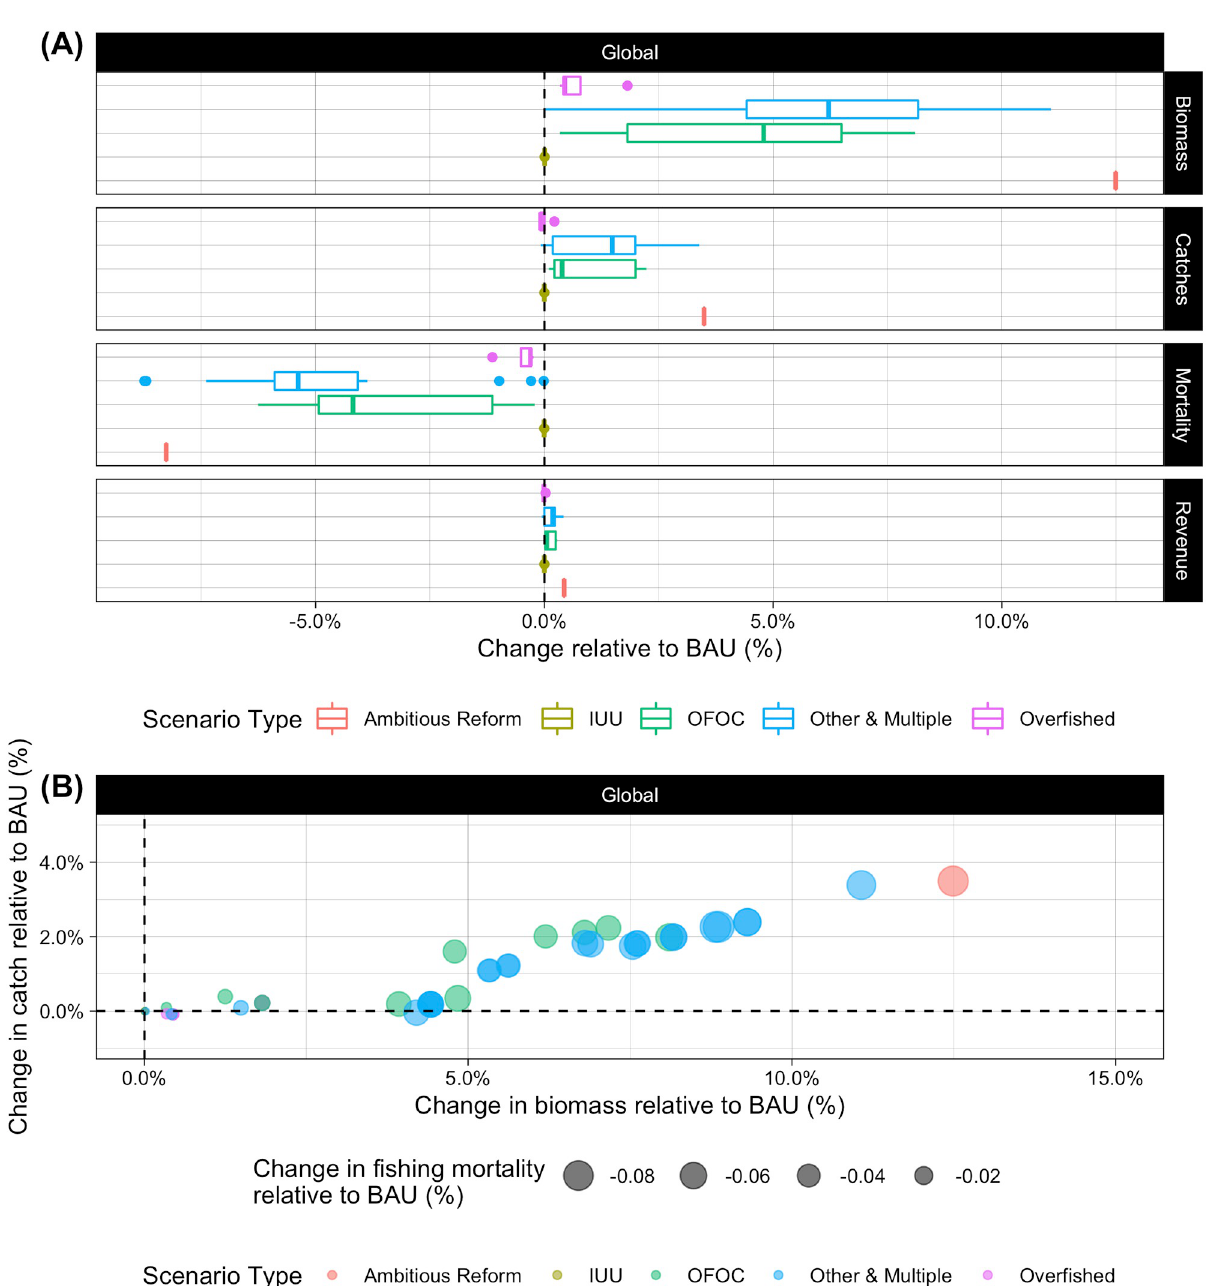
Fig 5. Global simulation model results (2050) for all pre-populated subsidy reform proposals included in SubsidyExplorer. In panel (A), changes in biomass, catch, fishing mortality, and revenue (%) are shown for different proposal types relative to a business as usual (BAU) scenario in which subsidy provisioning continues unchanged from 2018. The type of reform proposal is denoted by the color. Proposals may pertain to reforming subsidies to illegal, unreported, and unregulated (“IUU”) fishing, subsidies to fishing on overfished stocks (“Overfished”), subsidies contributing to overcapacity and overfishing (“OFOC”), or to multiple types (“Other & Multiple”). The “Ambitious Reform” scenario represents complete removal of all subsidies with the potential to be capacity-enhancing and thus represents the upper bound of effects seen from this model. Panel (B) shows changes in biomass (%) relative to BAU on the x-axis and changes in catch (%) relative to BAU on the y-axis for each individual proposal. Changes in fishing mortality (%) relative to BAU are denoted by the size of the point. The type of reform proposal is still denoted by the color of the